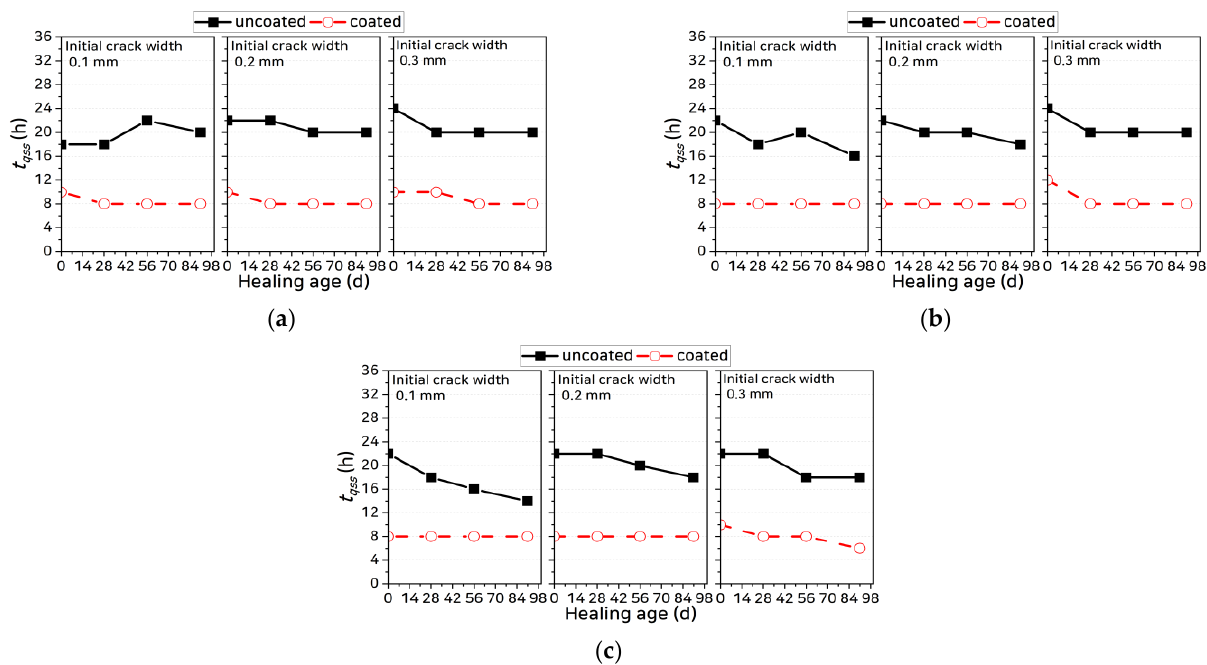
Figure 6. Comparison of times needed to reach the quasi-steady state: ( a ) OPC, ( b ) SHC15, and ( c ) SHC30.